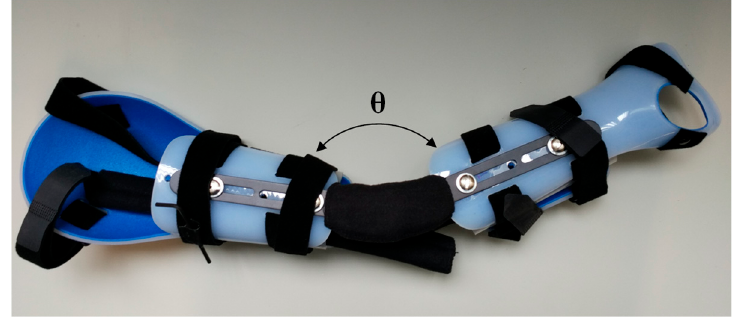
Figure 1. Custom made arm orthosis used in the present study, where θ represents the forearm angle.